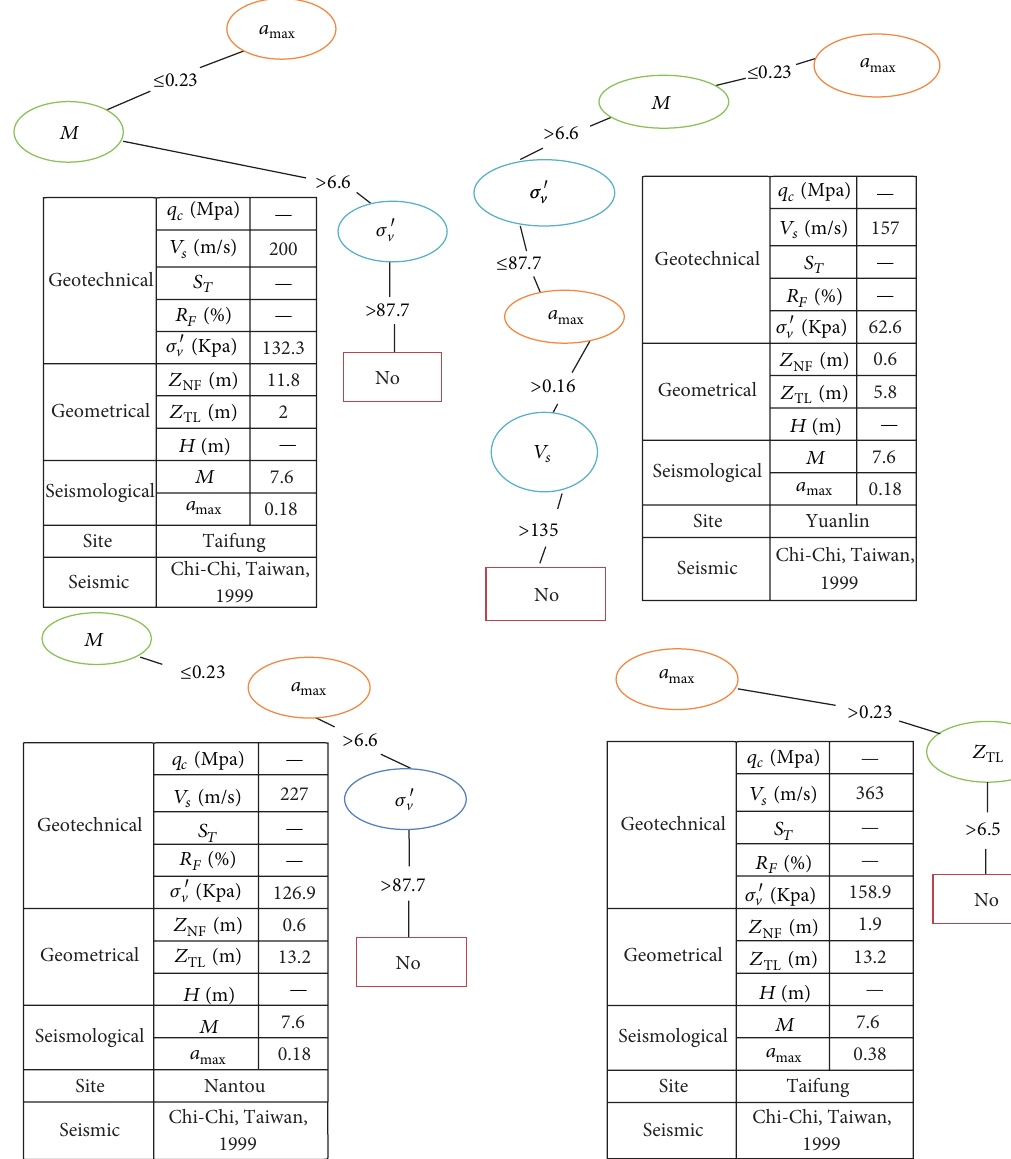
Figure 25: CLIP results for Chi-Chi, Taiwan,